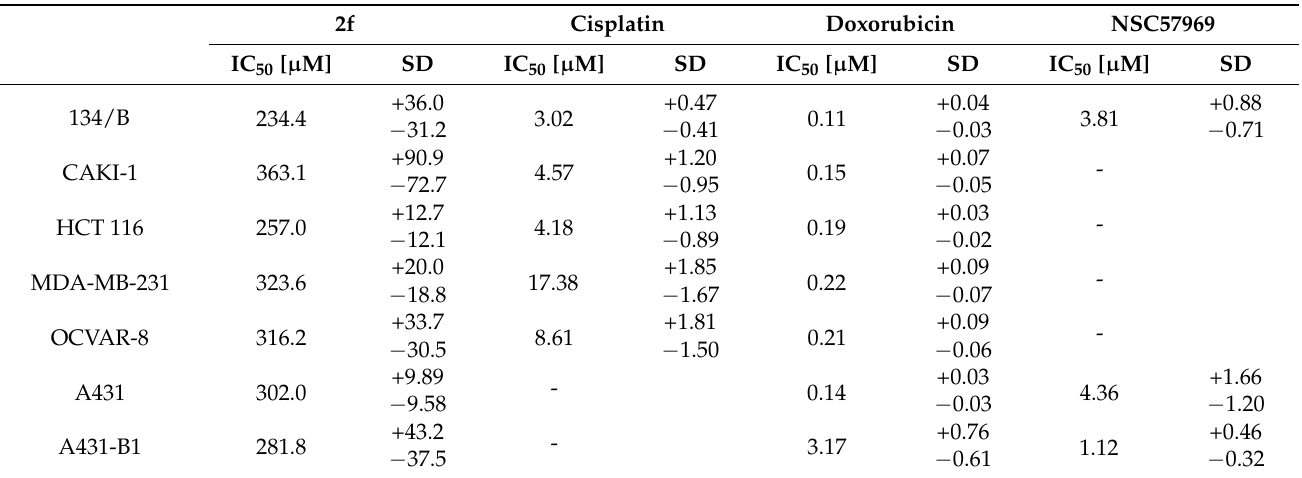
Table 6. Cytotoxicity of hydroxyphosphonate derivative 2f and control compounds against the panel of cell lines used. SD: standard deviation of IC 50